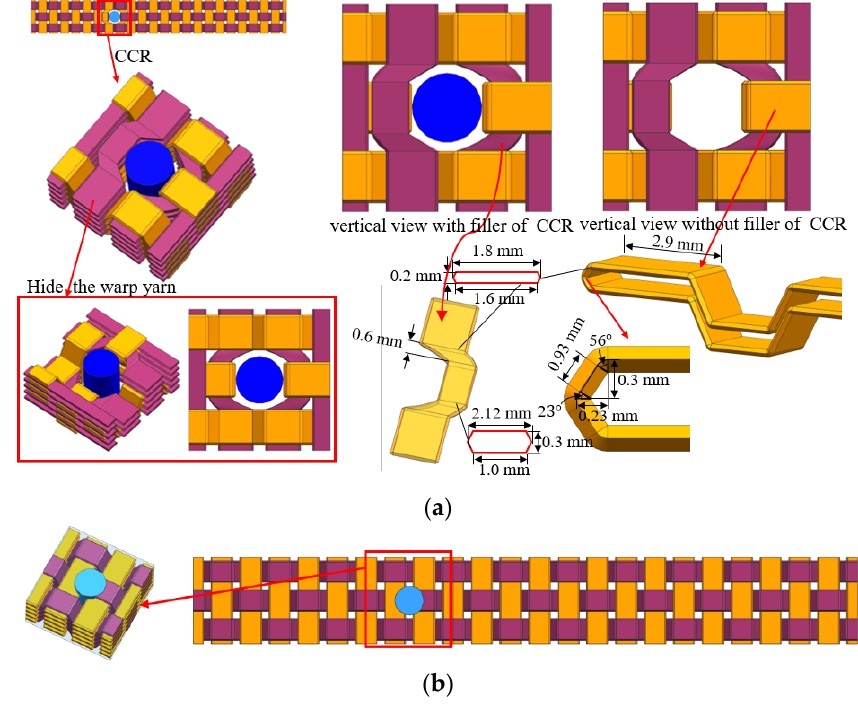
Figure 4. Schematic diagram of fiber deformation and modeling.